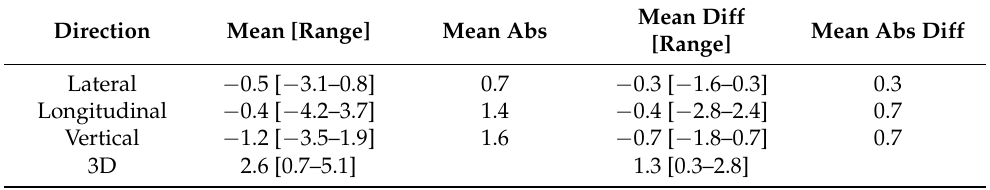
Table 1. Mean, mean absolute “abs”, and range of intrafraction prostate displacements during beam delivery in case B averaged over the 25 fractions that required an intervention due to excessive prostate motion. Values are provided in each of the three spatial directions and in 3D and are all expressed in mm. Mean differences from real shifts observed in the corresponding fractions are indicated by